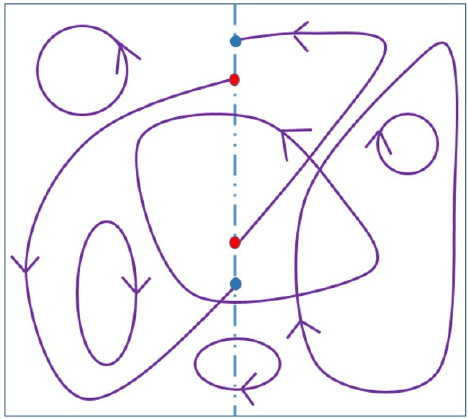
Figure 1 . The pure photon states are su- perpositions of closed loop con(cid:12)gurations of the electric (cid:12)eld, such as seen above.